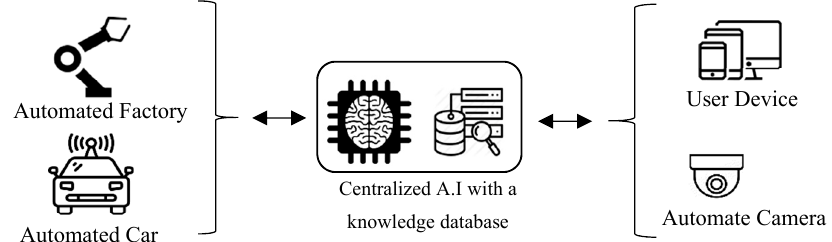
Figure 9. Traditional machine learning (ML) concept (centralized). AI, artificial intelligence.